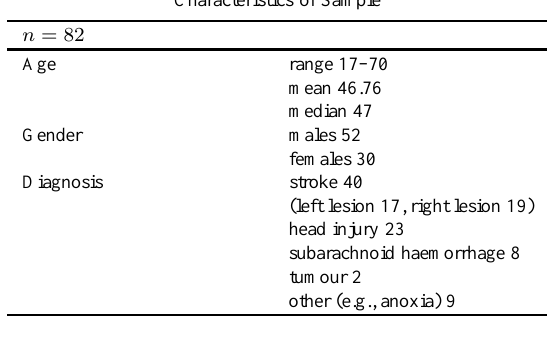
Table 2 Characteristics of